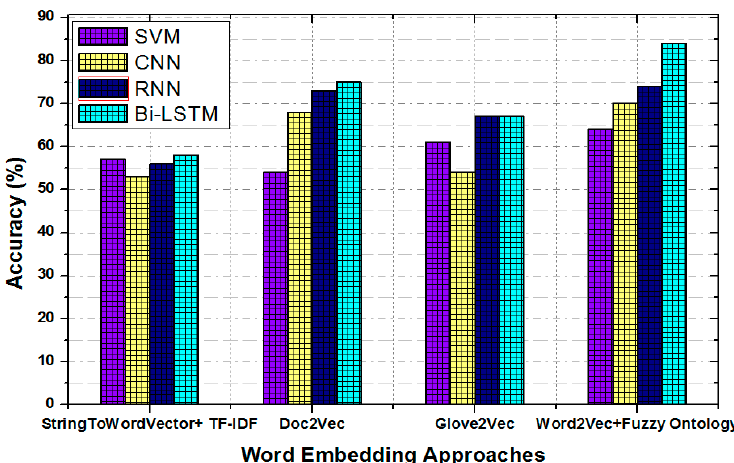
Figure 9. Classifier accuracy with different number of epochs.